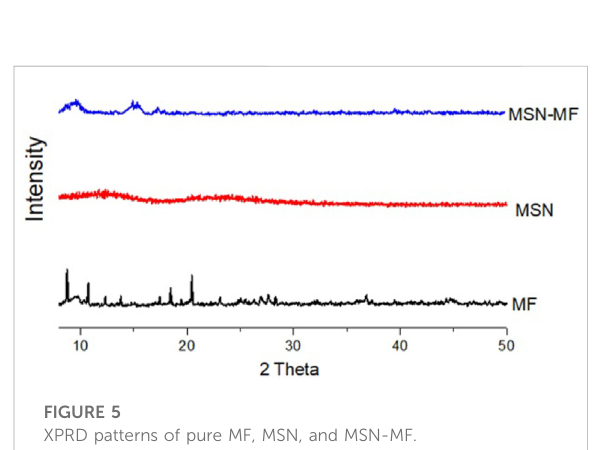
FIGURE 5 XPRD patterns of pure MF, MSN, and MSN-MF.